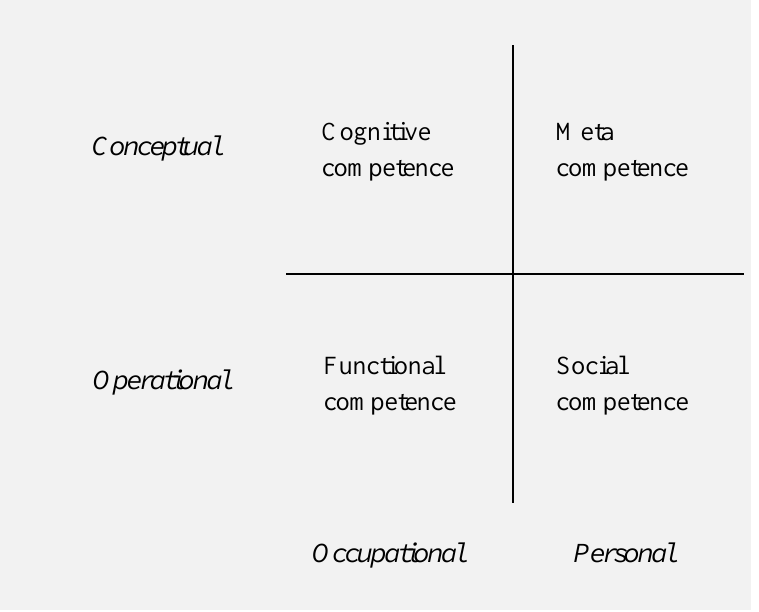
Figure 1 : The typology of competence by Winterton et al.